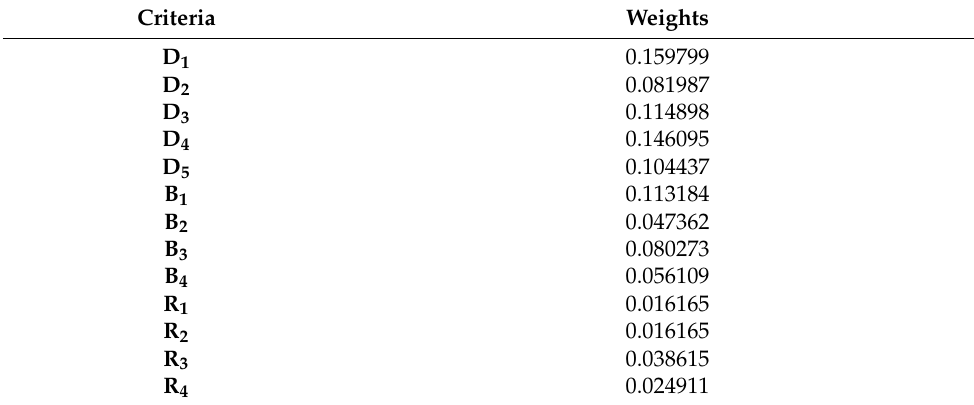
Table 4. Assumed weights for the decision-maker judgments.